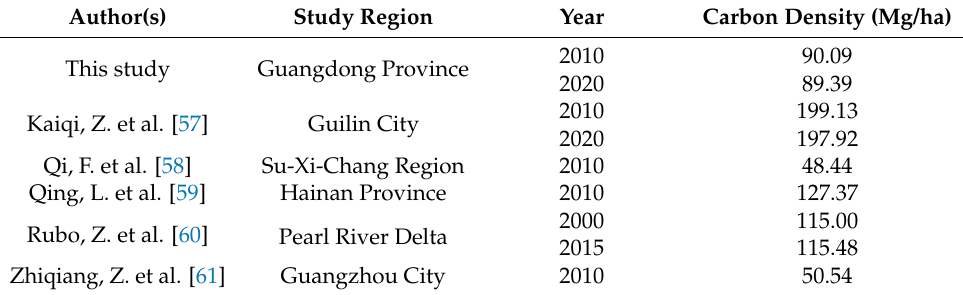
Table 6. Carbon storage in previous